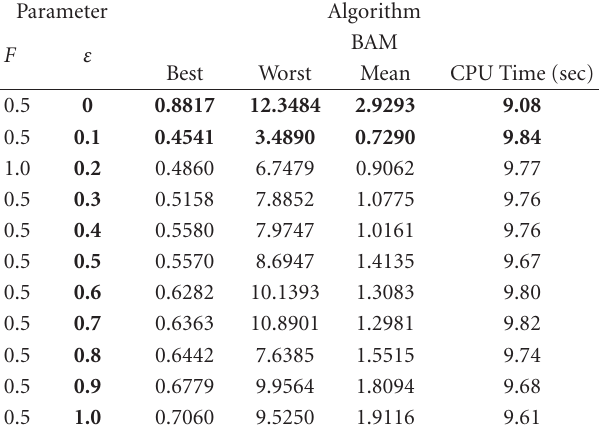
Table 19: Best normalized optimization results and average CPU time on UCAV path planning problem on di ff erent ε . The numbers shown are the best results found after 100 Monte Carlo simulations of BAM